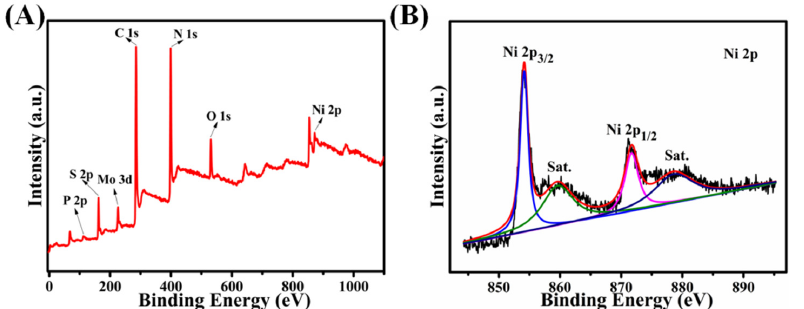
Figure 3. ( A ) XPS spectra of 1 . ( B ) Detailed spectrum of the nickel Ni 2p peaks of 1 (red: Ni 2p; blue: Ni 2p3/2; pink: Ni 2p1/2; black: standard curve).